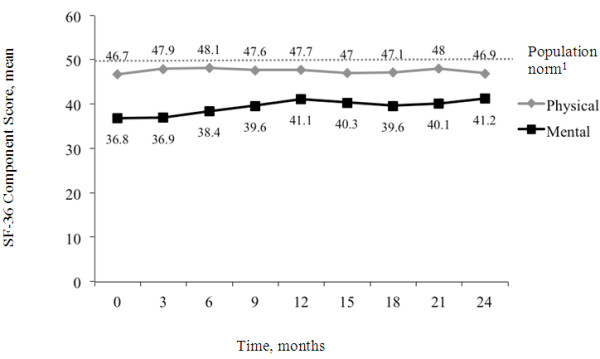
Mental and Physical Health Assessment at Each Visit During the 24-Month Study. Mental and Physical health were assessed using the Short-Form Health Survey (SF-36). 1 Population norm as provided by the SF-36 organization
http://www.sf-36.org/tools/SF36.shtml.